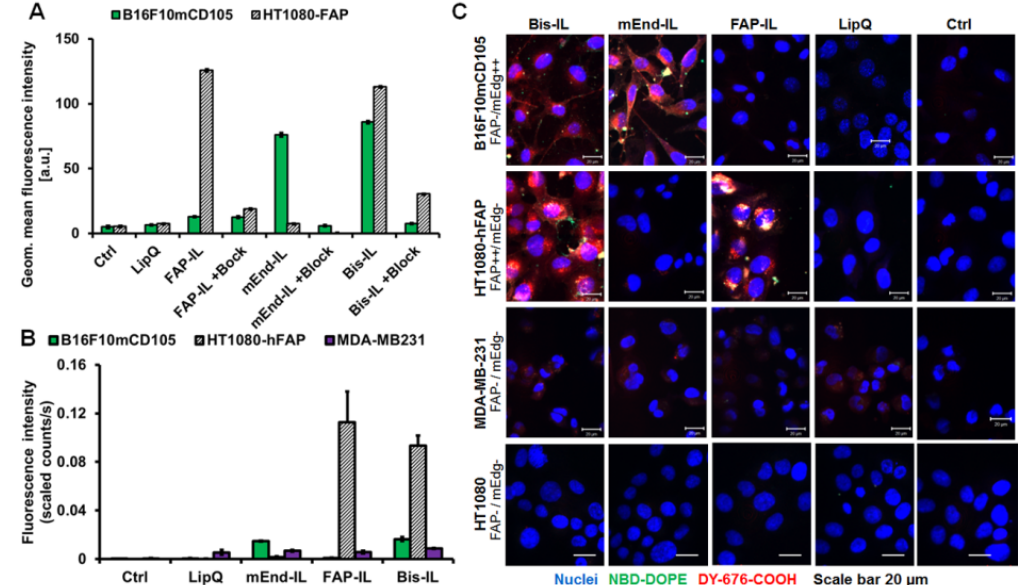
Figure 3. Selectivity of binding, uptake and activation of liposomes by cultured target cells. ( A ) Flow cytometric analysis of the liposomal green fluorescent phospholipid on the surface of FAP positive (HT1080-hFAP) and murine endoglin positive (B16F10mCD105) cells treated with the indicated liposomes alone or in the presence of free scFv as competitive blocker for 2 h at 4 °C. In the presence of the free FAP’scFv (+Block for the HT1080-hFAP) or free mEdg’scFv (+Block for the B16F10mCD105) binding is significantly ( p < 0.001) reduced. Each bar represents the mean of 2 (with block) or 3 independent measurements and the standard deviation (S.D.). ( B ) Semi-quantitative levels of the fluorescence intensity of liposomal DY-676-COOH in cell pellets after incubation with 200 nmol (final lipids) of the respective liposomes for 8 h at 37 °C. Each bar depicts the mean of n = 3/SEM. Statistical significance ( t test): p < 0.001 for FAP-IL and Bi-FAP/mEnd-IL versus mEnd-IL and LipQ in the HT1080-hFAP cells. ( C ) Confocal microscopic images of the indicated cell lines after treatment with 200 nmols (final lipids) of the indicated liposomes for 8 h at 37 °C.